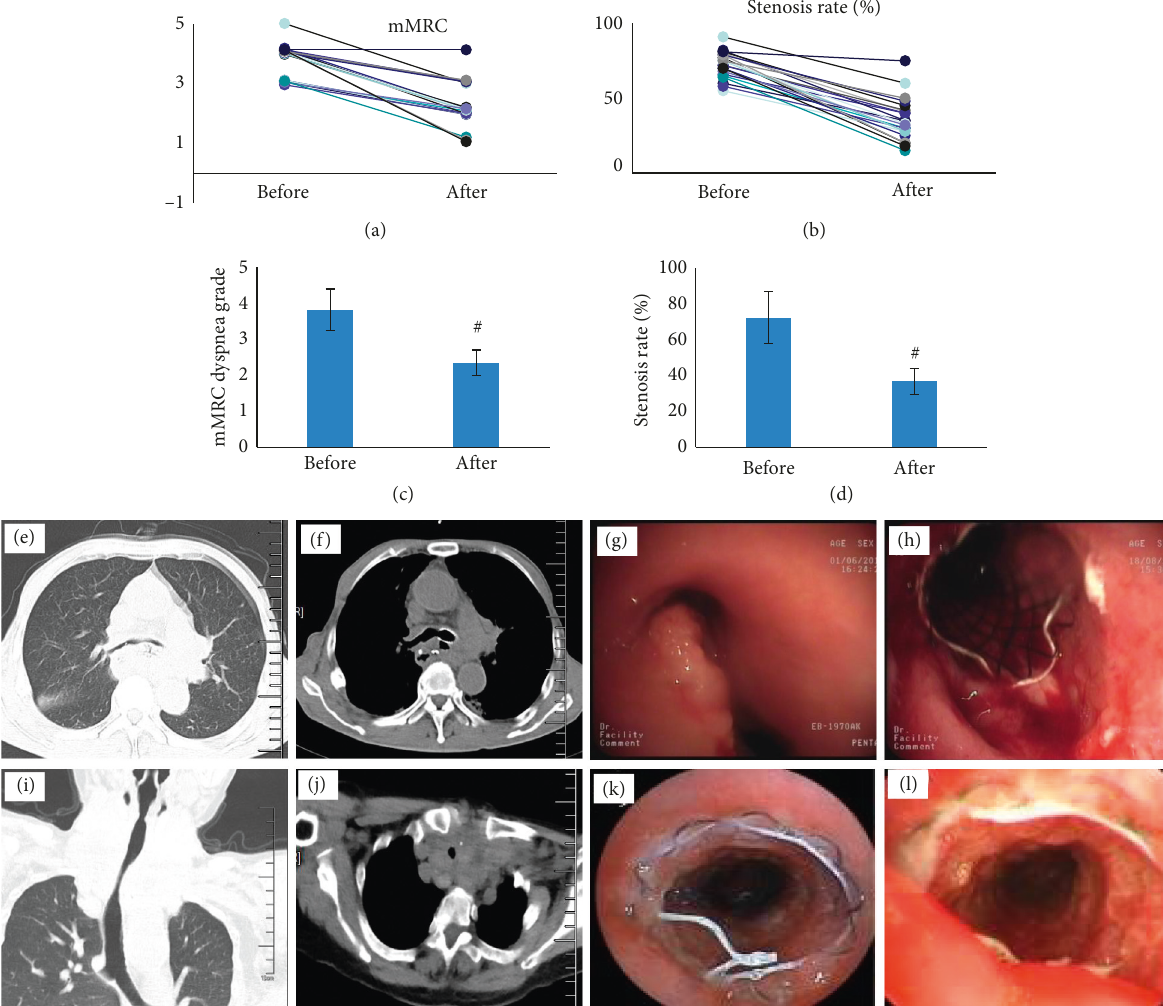
Figure 3: (a, c) The mMRC dyspnea grade of patients before and after TTS stent implantation. (b, d) The stenosis rate of all patients before and after TTS stent implantation. (e–h) CTscan and TTS stent implantation in a esophageal cancer patient six months after operation. (i–l)